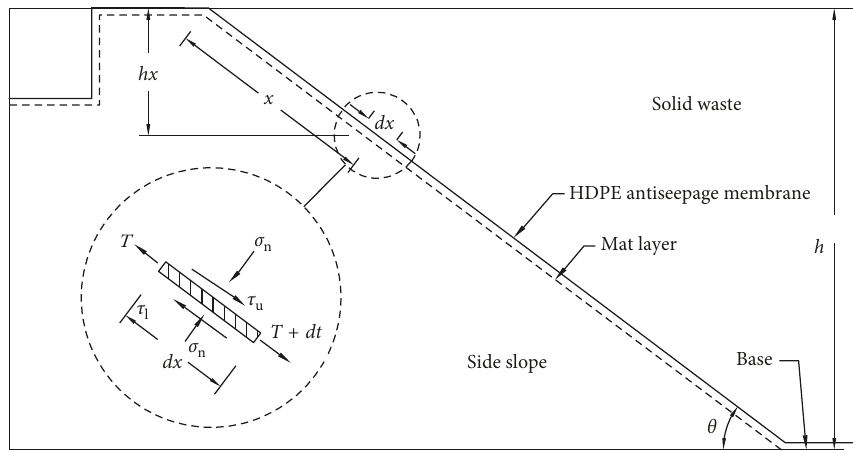
Figure 1: Schematic model of antiseepage membrane installed on industrial waste landfill slopes.